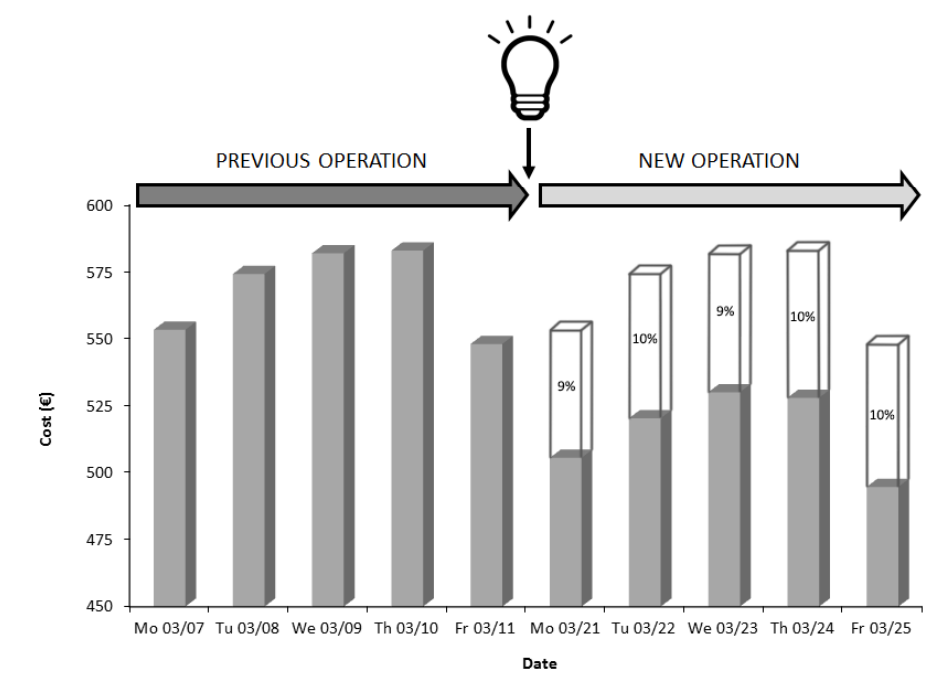
Figure 6. Building 8G energy costs before and after the EEM.